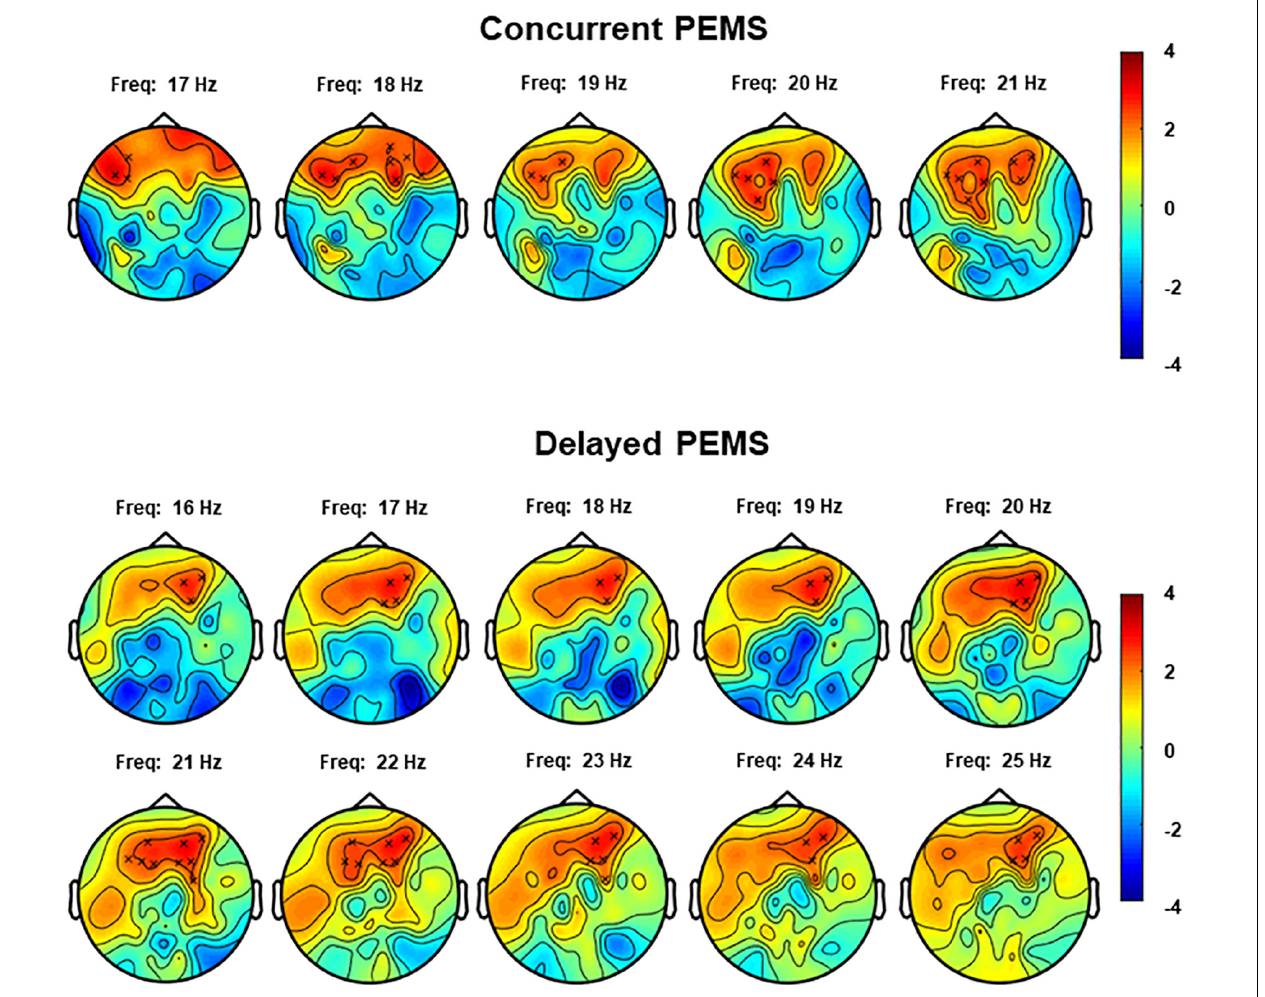
FIGURE 5 | Topoplots for the cluster-based permutation test that compared resting-state EEG power (4–30 Hz) before and after concurrent and delayed stimulation. Each plot shows the largest positive cluster (indicated by the “x” markers) that demonstrated a difference between EEG power before and after PEMS, plotted on top of the t-statistic of the difference as calculated for every frequency-electrode pair (repeated-measures t -test). The cluster showed a difference most pronounced over frontal regions and in the frequency range of 17–21 Hz for concurrent PEMS and 16–25 Hz for delayed